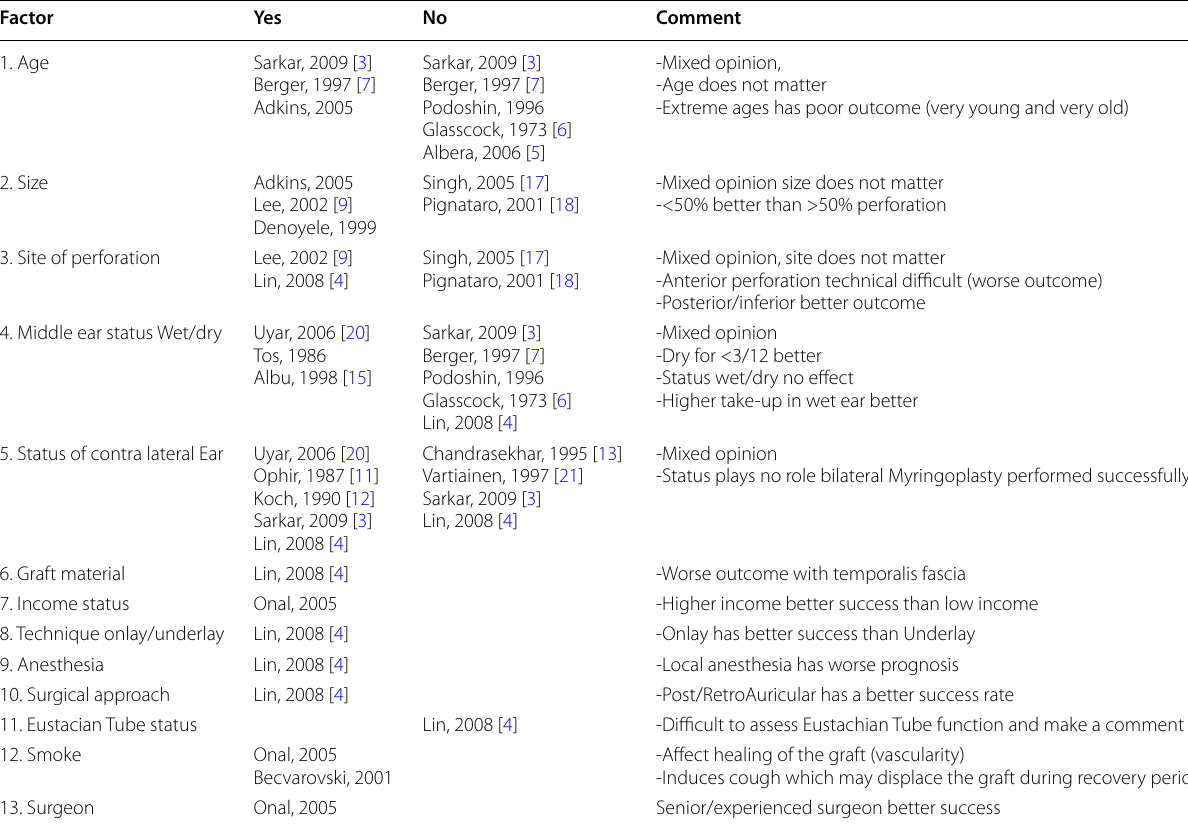
Table 6 Review of different prognostic factors [4, 5, 17] Factor Yes